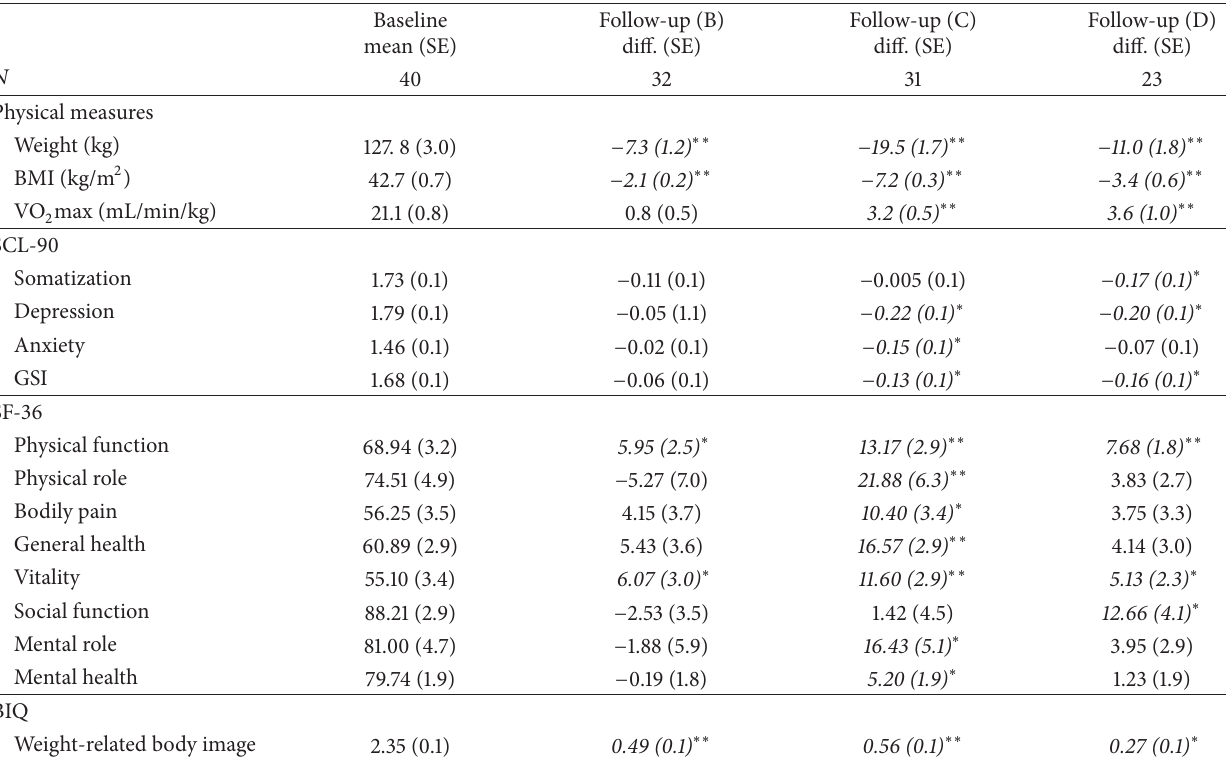
Table 1: Improvement of weight, BMI, physical fitness (VO 2 max), mental health (SCL-90), HRQOL (SF-36), and body image (BIQ) from baseline to time point (B), from time point (B) to time point (C), and from time point (C) to time point (D). SE: standard error; GSI: General Severity